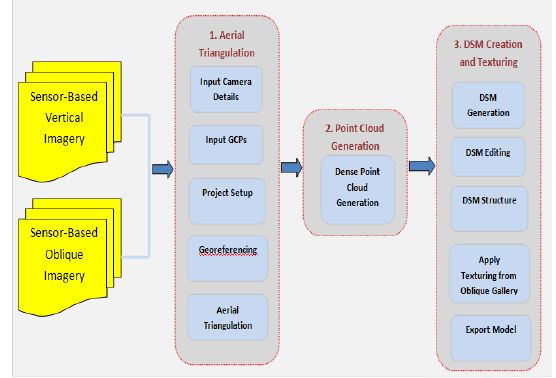
Figure 3. Processing Workflow